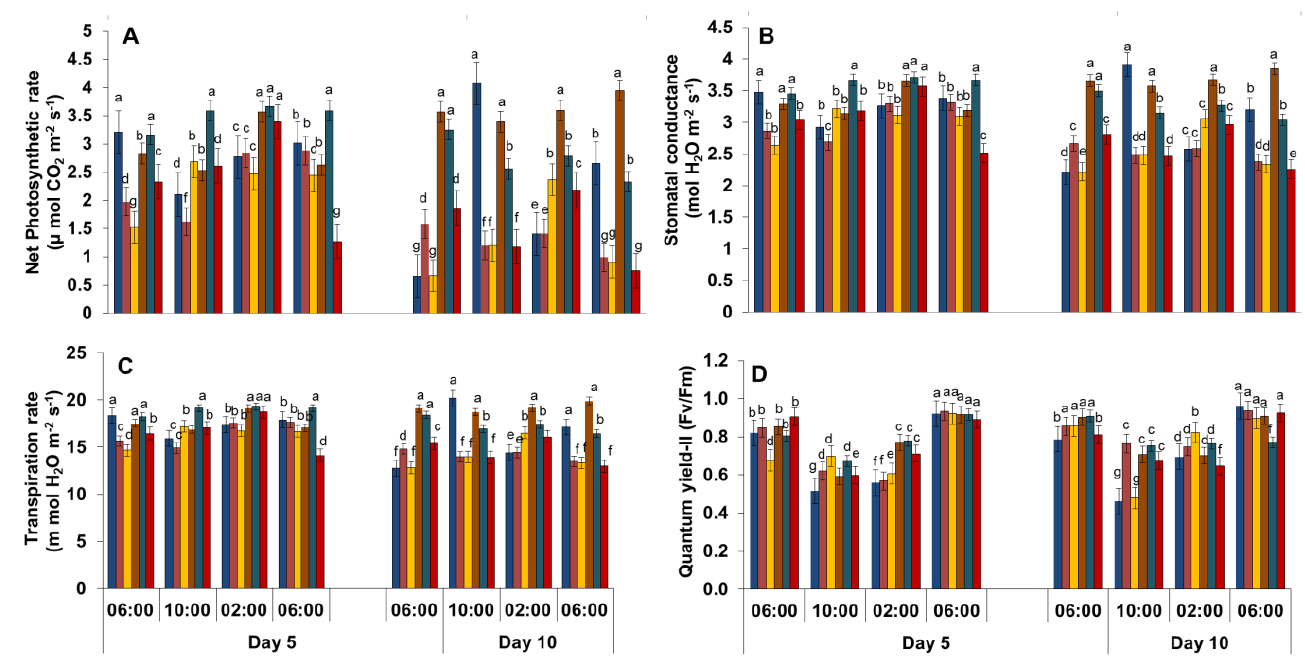
Figure 6. ( A ) Net photosynthetic rate, ( B ) stomatal conductance, ( C ) transpiration rate, and ( D ) PSII- quantum yield in spinach genotypes Delhi green (DG) and Malav Jyoti (MJ). Results are presented for the controls (MJ control; DG control), 20 mM of NaCl treatments (MJ-20 mM; DG-20 mM), and 50 mM of NaCl treatments (MJ-50 mM; DG-50 mM). Sampling was performed (on the basis of the circadian cycle) at intervals of about 4 h which were at the exact times of 6 am, 10 am, 2 pm and 6 pm of both day 5 and day 10 of salinity stress. Vertical bars indicate mean ± S.E. for n = 3. Means with different letters are significantly different at p ≤ 0.05 according to the Tukey’s studentized range test. Data for day 5 and day 10 are shown separately and the colors of the bars correspond to treatments, which remain the same for different hours.